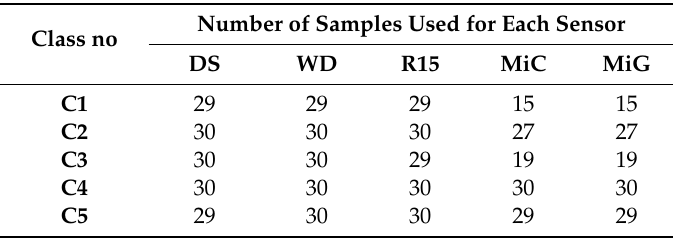
Table 1. Number of samples used for each sensor related to the class considered. Class